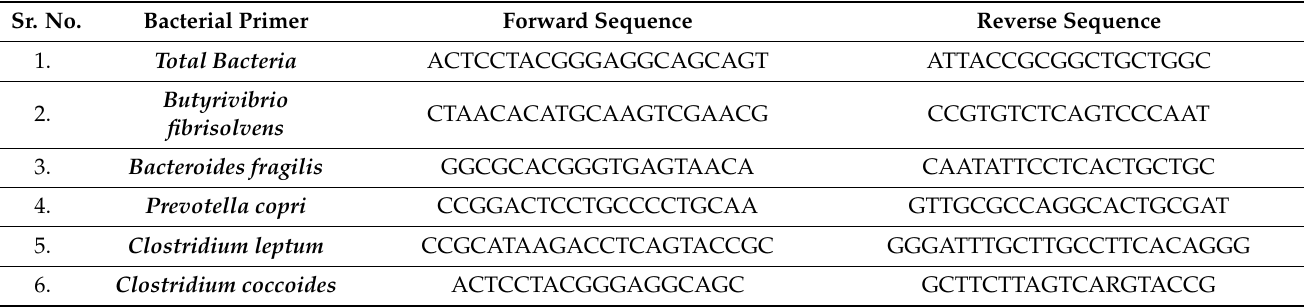
Table 1. List of bacterial